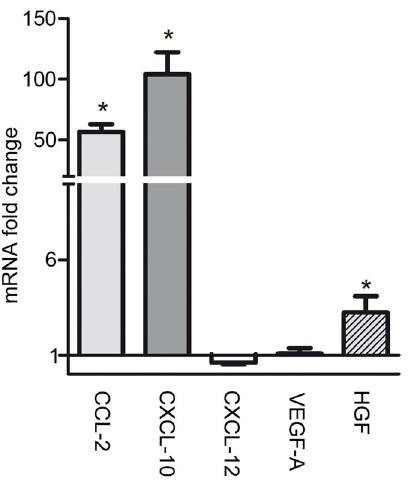
Figure 3. mRNA expression of chemokine and growth factors in the corpus callosum at week 4 of cuprizone feeding. The change of mRNA expression of CCL-2, CXCL-10, CXCL-12, VEGF-A, and HGF in the corpus callosum is shown at the time point of MSC application. Significant differences between untreated and cuprizone treated groups are indicated by asterisks (* P , 0.05, ** P , 0.01, *** P ,